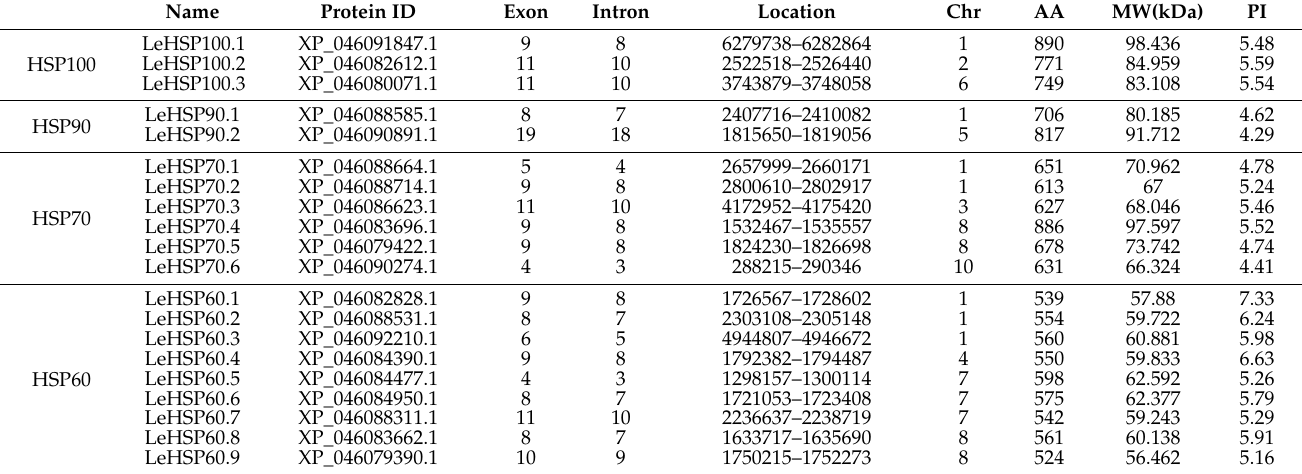
Table 1. Molecular features of Hsp genes in L. edodes